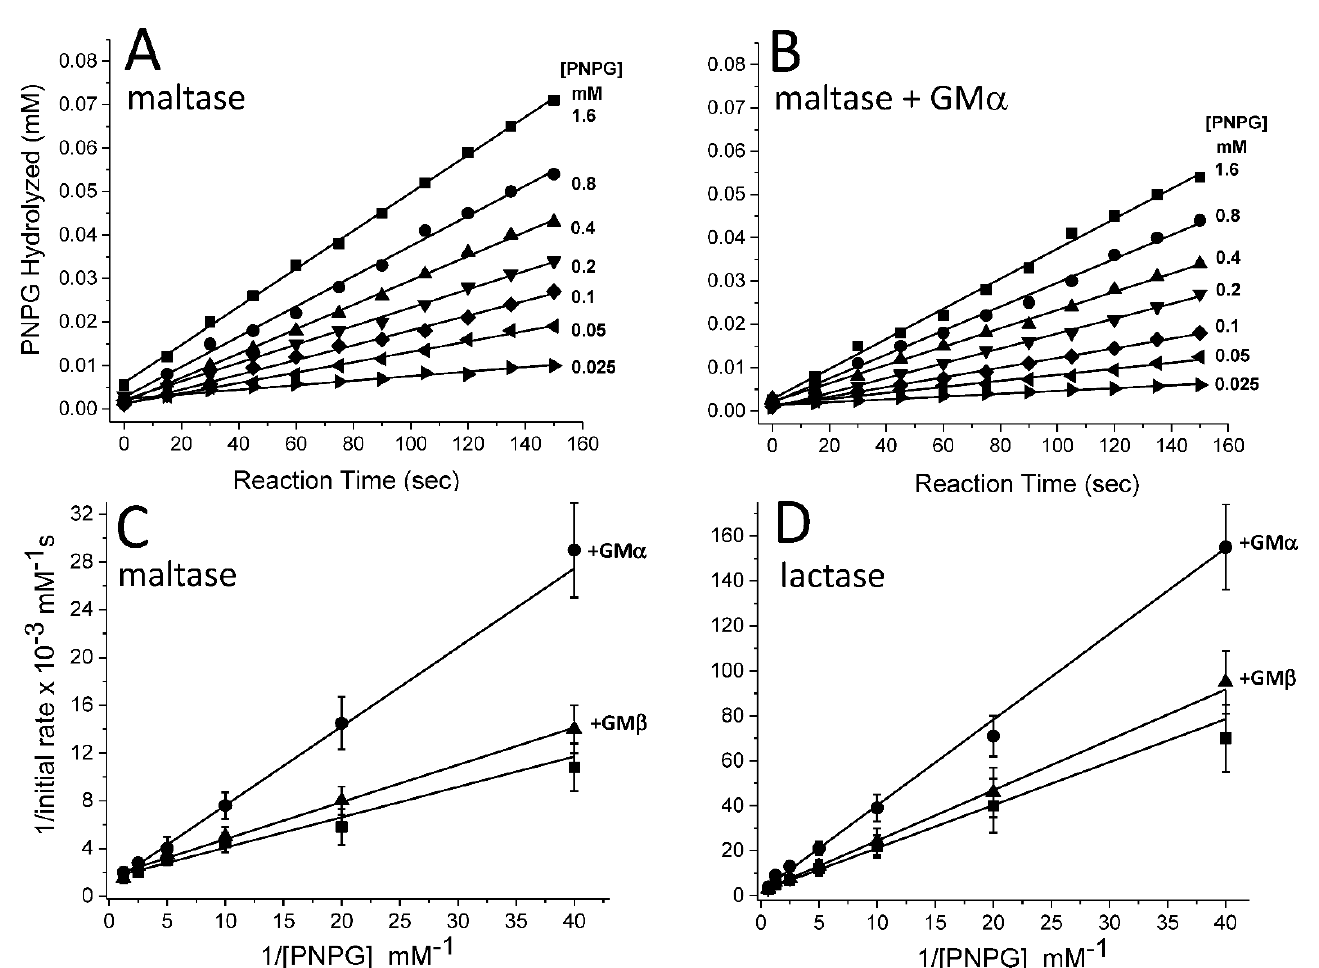
Figure 9. Colorimetric PNPG assays with maltase and lactase. ( A ) The amount of para- α -nitrophenyl- D-glucopyranoside ( α -PNPG) hydrolyzed by maltase (1 unit) is shown for α -PNPG concentrations from 0.025 mM to 1.6 mM, as indicated in the figure. ( B ) The amount of α -PNPG hydrolyzed by maltase (1 unit) in the presence of GM α (2 mg/mL) is shown for α -PNPG concentrations from 0.025 mM to 1.6 mM, as indicated in the figure. Using initial rates of hydrolysis (e.g., those with maltase shown ( A , B )), Lineweaver–Burk plots are shown for PNPG (para- α - or para- β -nitrophenyl- D-glucopyranoside) hydrolysis in the presence of maltase ( C ) and lactase ( D ) in the absence and presence of 2 mg/mL GM α or 8 mg/mL GM β . From the analyses of these data, the V max and K M parameters are given in Table 2. Error bars indicate the standard deviations of 3 or 4 different experiments, each run in duplicate.